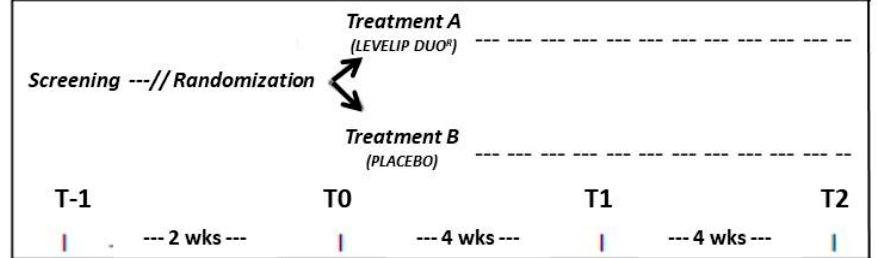
Figure 1. Study design.